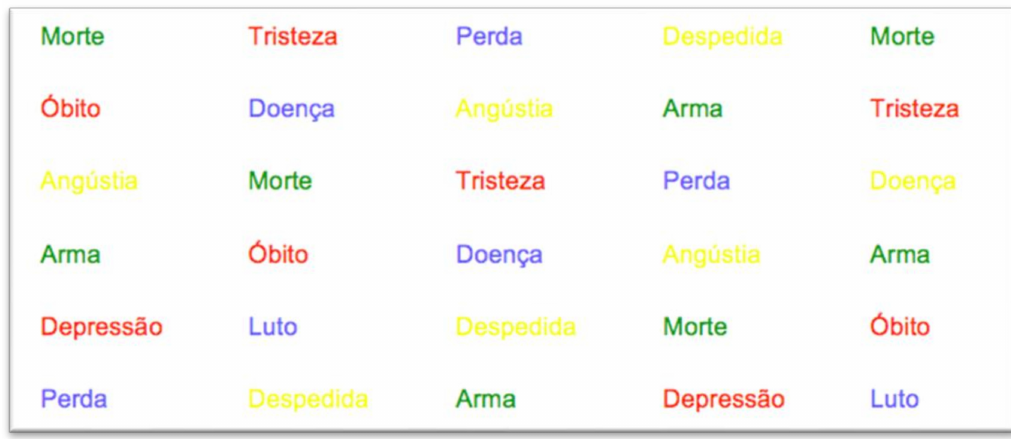
Figure 3. The ten negative